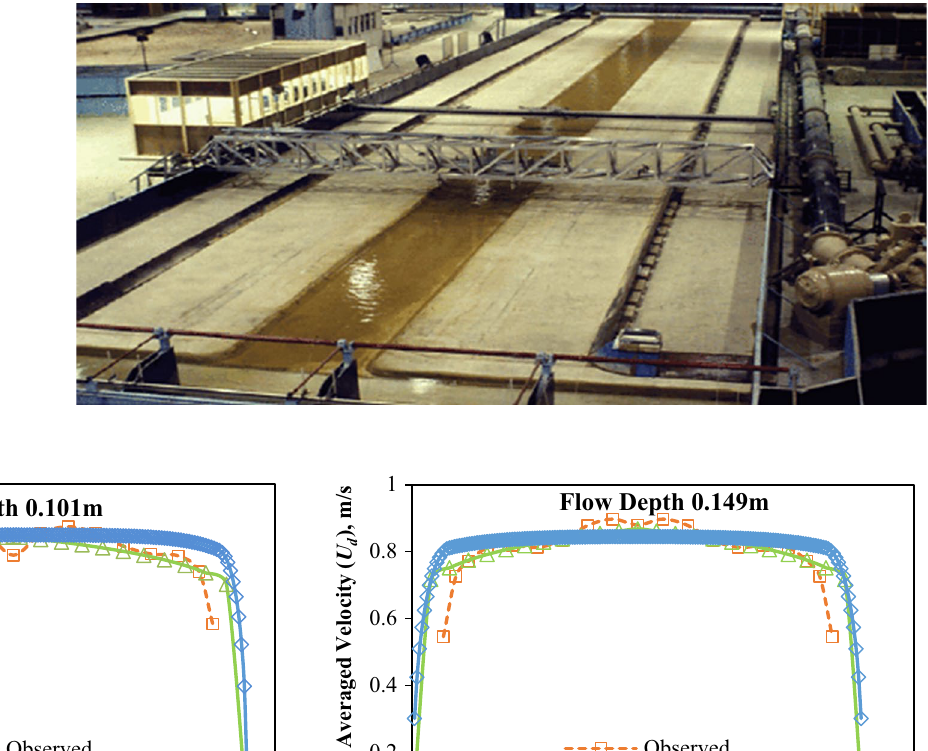
Fig. 12 Experimental channel of SERC facility at Wallingford (FCF), UK